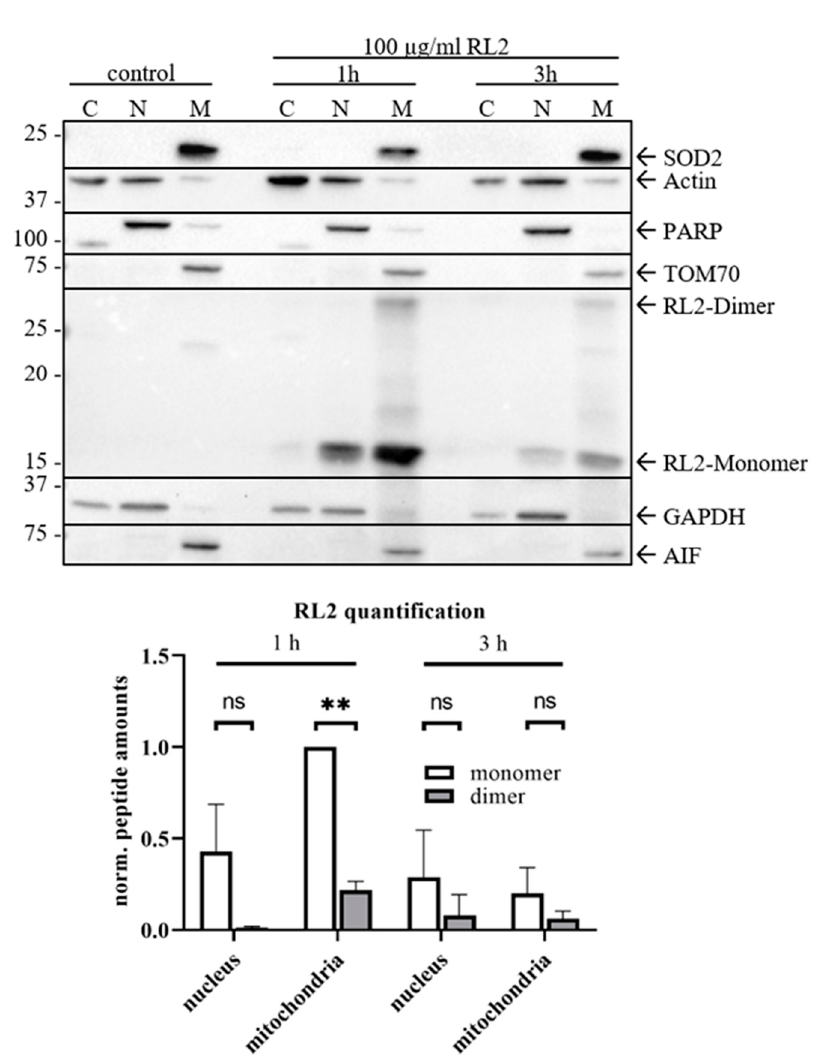
Figure 5. Internalized RL2 is localized at mitochondria. MDA-MB-231 cells were stimulated with 100 µg/mL RL2 for indicated time points. Cellular fractionation for cytoplasm (‘C’), nucleus (‘N’) and mitochondria (‘M’) was performed. The fractions were subjected to Western Blot analysis with indicated antibodies. SOD2, Actin, GAPDH and PARP were used as fraction control. The bands corresponding to RL2-Monomer and -Dimer were quantified by ImageLab 5.1 beta (Bio-Rad) from three independent experiments. The statistical analysis was performed by paired student t -test (bottom panel). One representative Western Blot out of three is shown in Figure S4. ns (not significant; p > 0.05), ** (significant; p < 0.01).